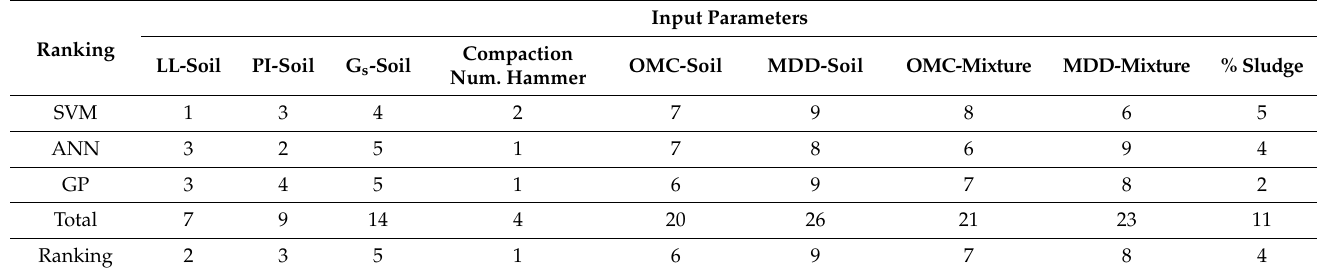
Table 11. The importance of different input parameters for all AI